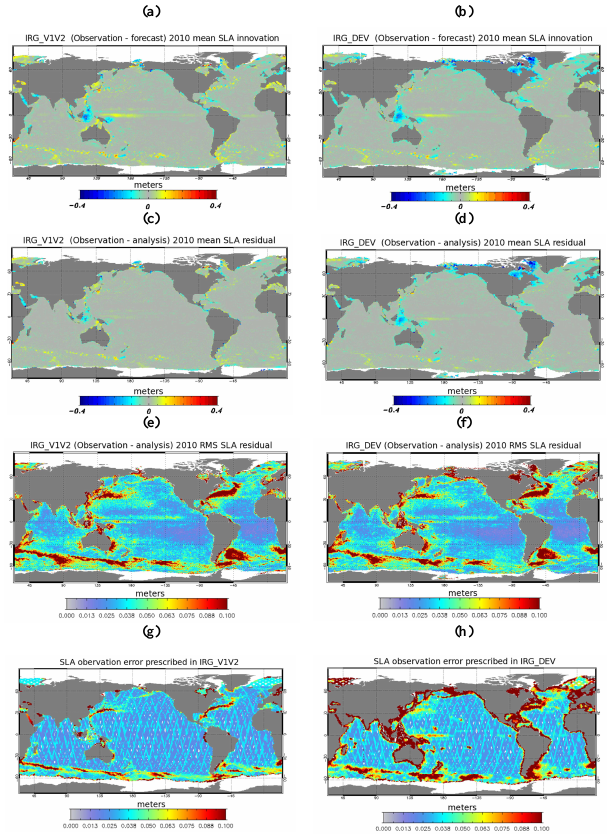
Fig. 15. SLA innovations ( a and b ), SLA residuals ( c and d ) and SLA RMS residuals ( e and f ) for the IRG V1V2 ( a , c and e ) and IRG DEV ( b , d and f ). Specified SLA observation error for IRG V1V2 (g) and IRG DEV (h) . These diagnostics (in meters) il- lustrate the forecast and analysis scores. These scores are averaged over all seven days of the data assimilation window, with a lead time equal to 3.5days.